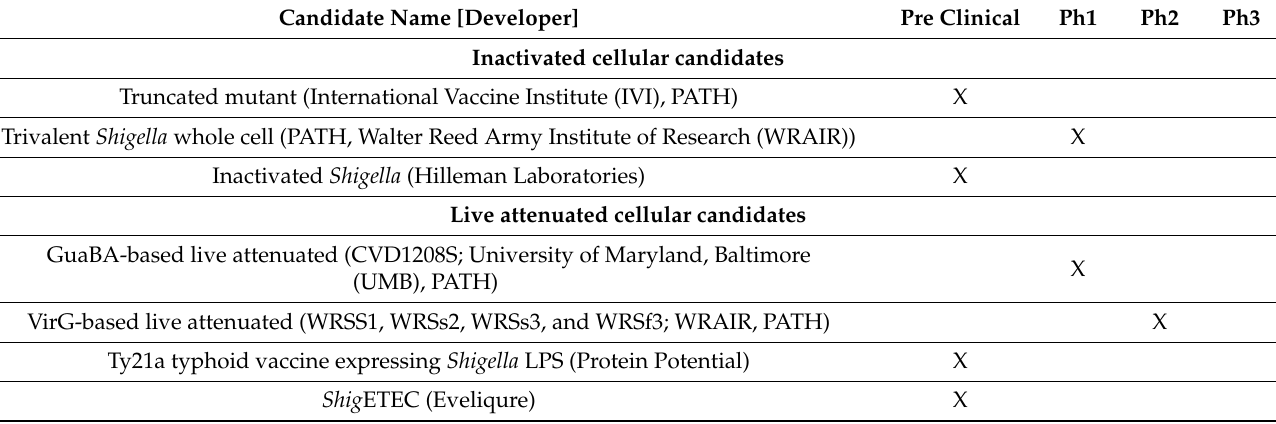
Table 1. Shigella vaccine candidates (in development or previously found